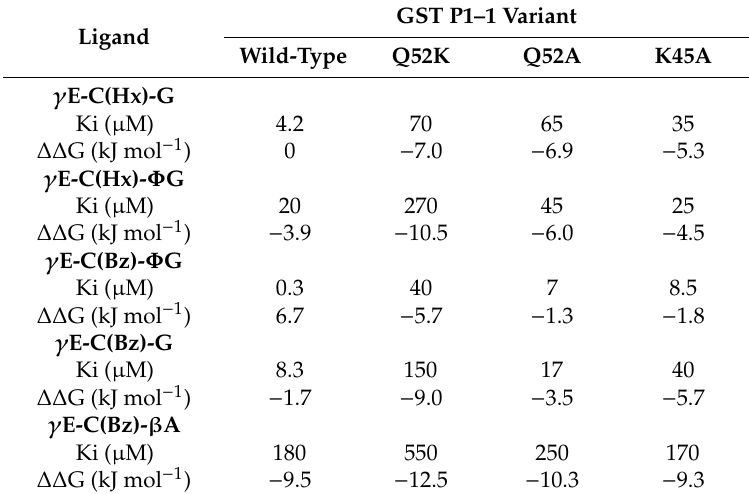
Table 5. Inhibitions constants and incremental binding energies as determined from inhibition studies with glutathione